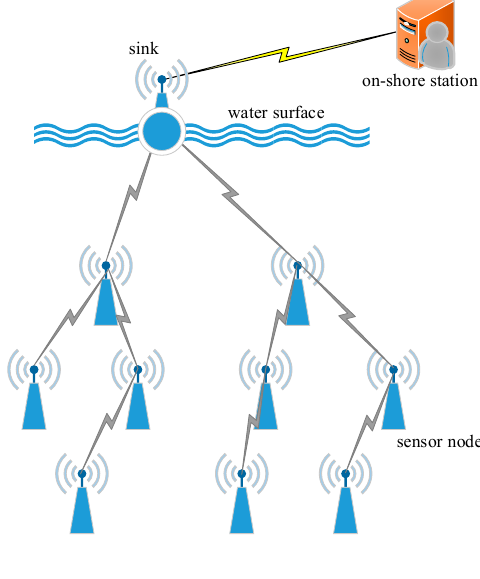
Figure 1. System